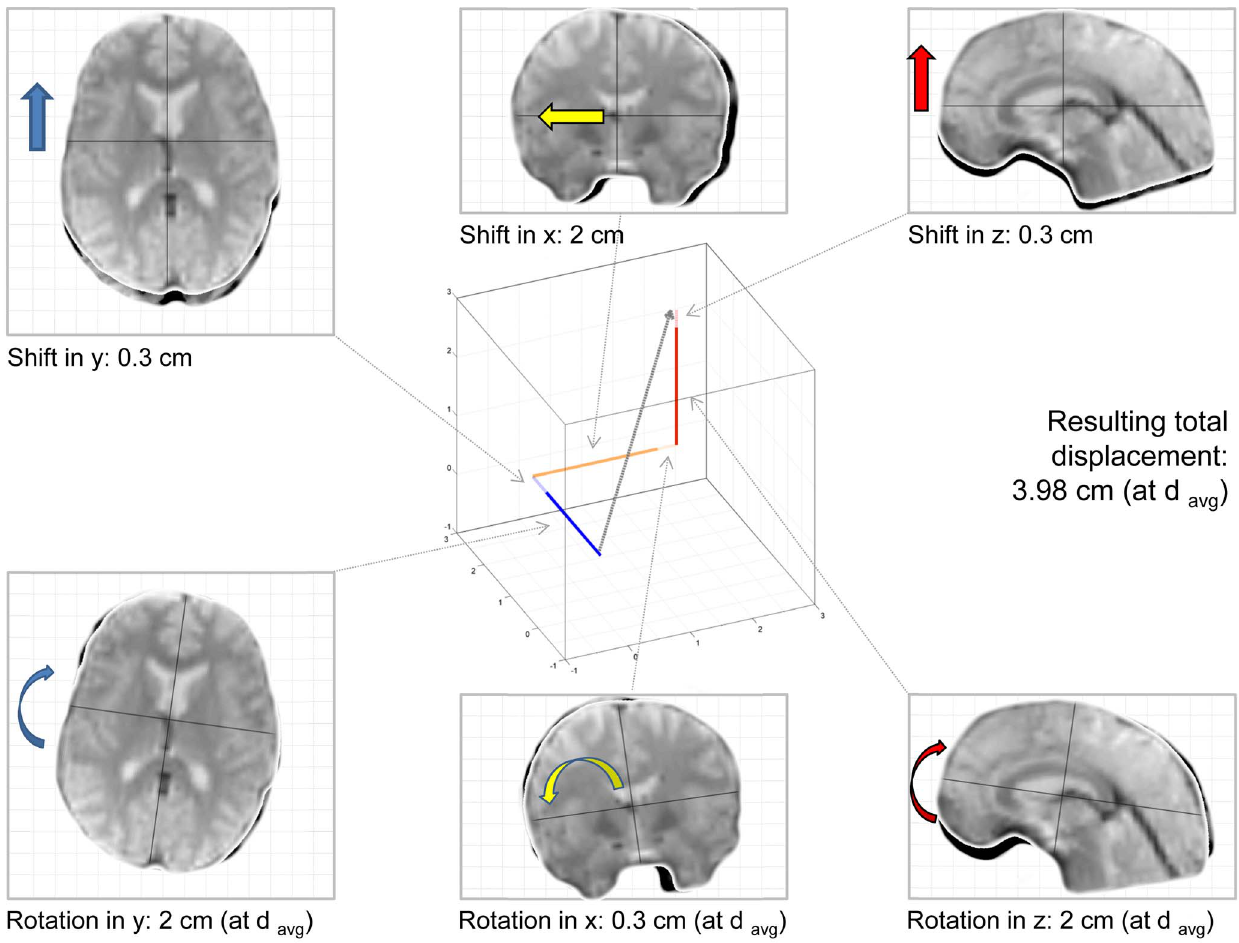
Figure 1. Illustration of the non-linear effects of combining translations (top row) and rotations (bottom row) into a single measure of total displacement (resulting gray arrow in the Cartesian coordinate system, middle). The values provided are only examples. Note that in this example, all displacements are additive, which is not always the case (see manuscript for more details). Note: d avg is a measure of the average cortical distance, required to transform rotations to absolute distances.